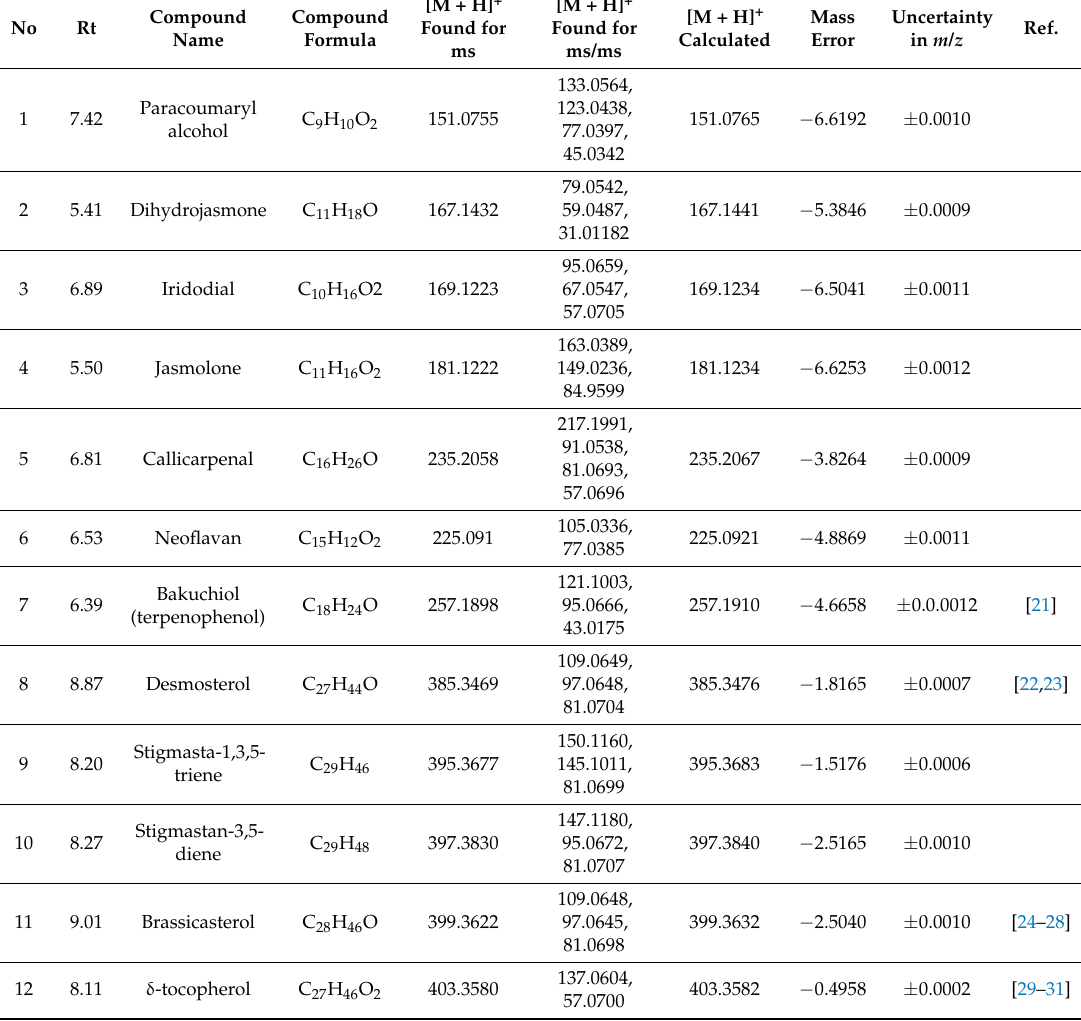
Table 3. LC-MS/MS analysis of hexane crude extracts of A. lagopoides